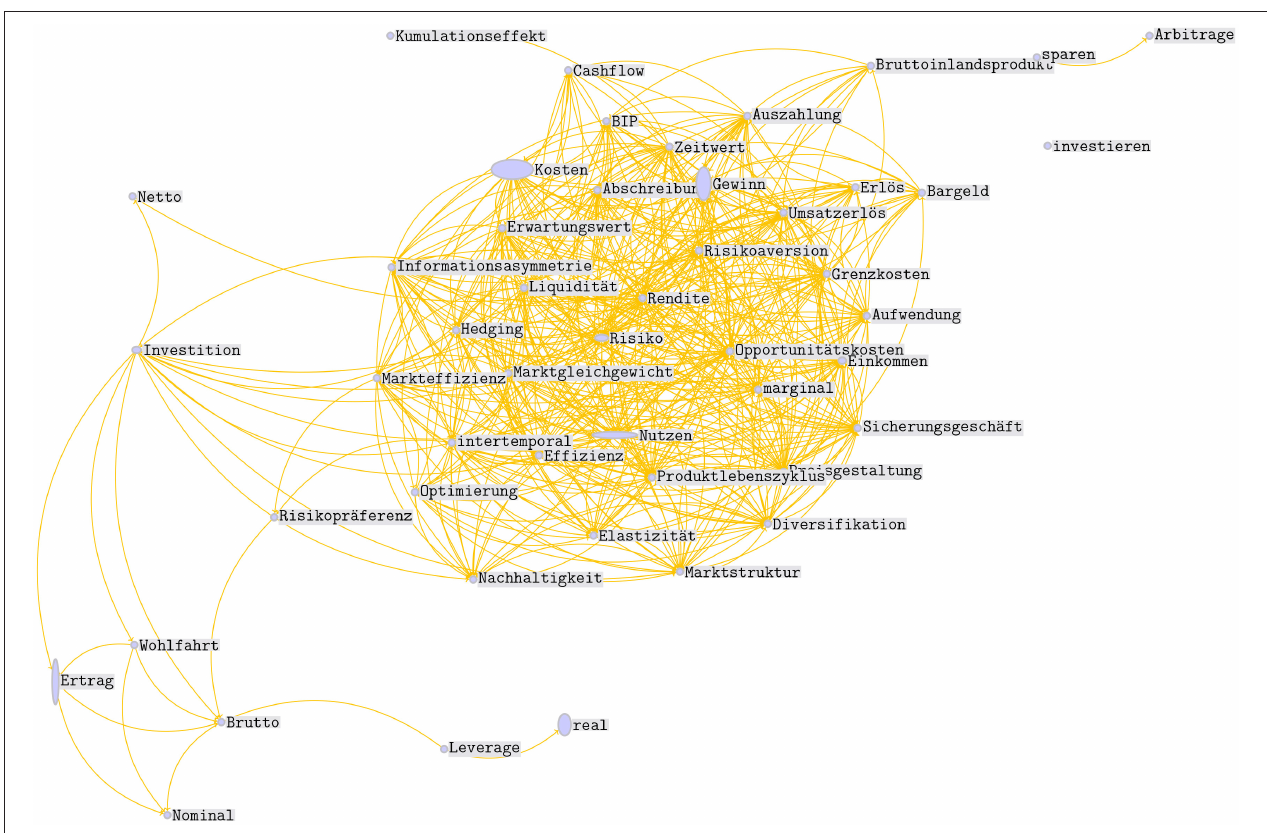
FIGURE 7 | Alpha-cut graph C ( T , α ) of the TCN based on WP-Eco for α = 0.7. Vertex height: compounding-specificity; vertex width: sentence-specificity. For the vertices’ translations see Appendix A .